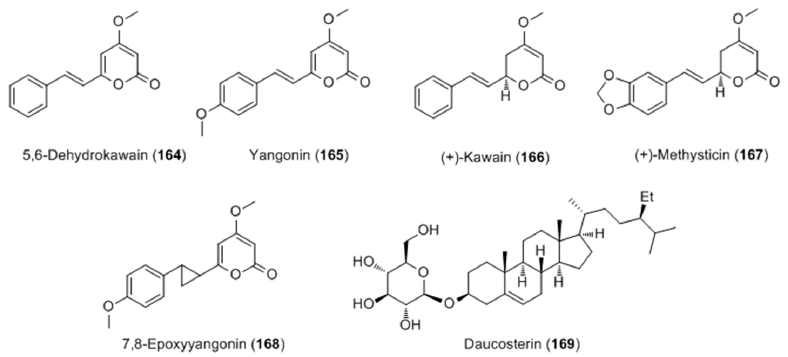
Figure 33. Structure of kavalactones and glucosylsterols isolated from the rhizome extract of Piper methysticum .